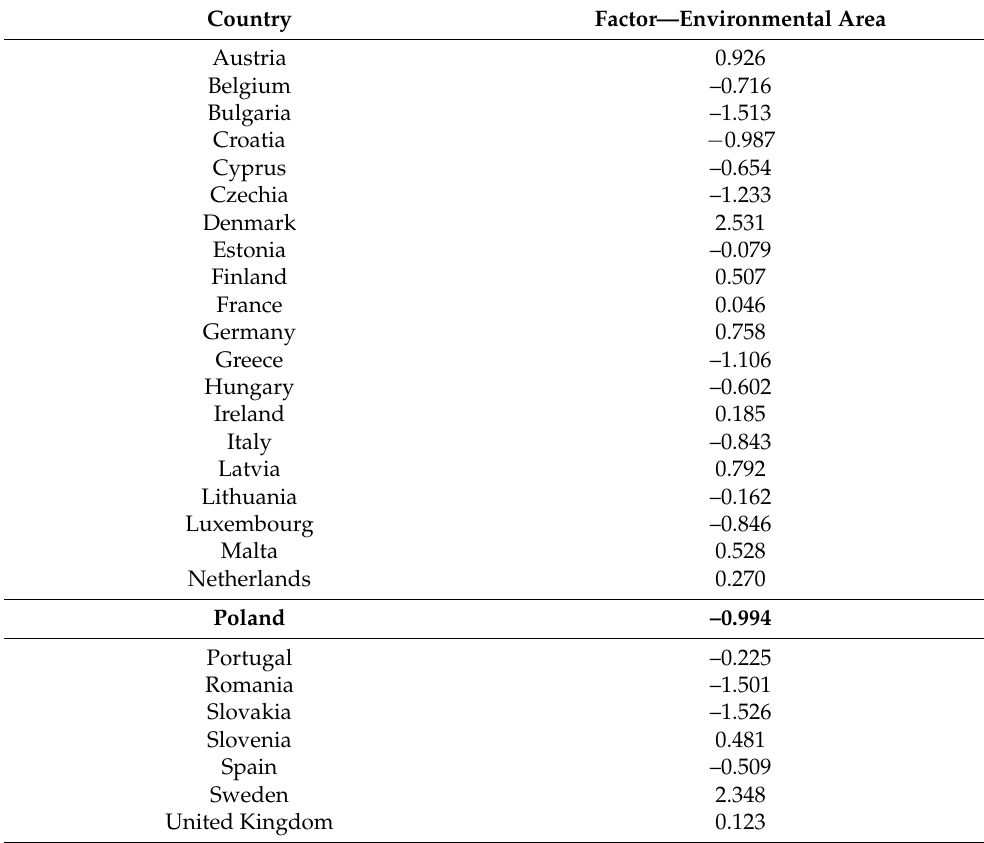
Table 10. Values of selected factors in the EU countries together with medians of factors of the environmental area for EU-13 and